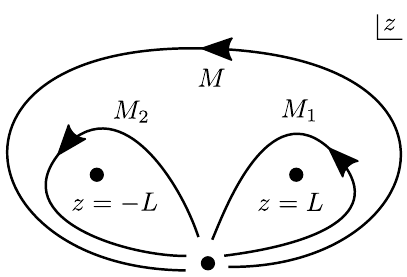
Figure 3 . The monodromy structure in the near region. At z = (cid:6) L we have singularities corre- sponding to the position of the supertubes. When going around one of them, ( F; G ) gets transformed by M i . Going around both of them induces a monodromy transformation M = M 2 M 1